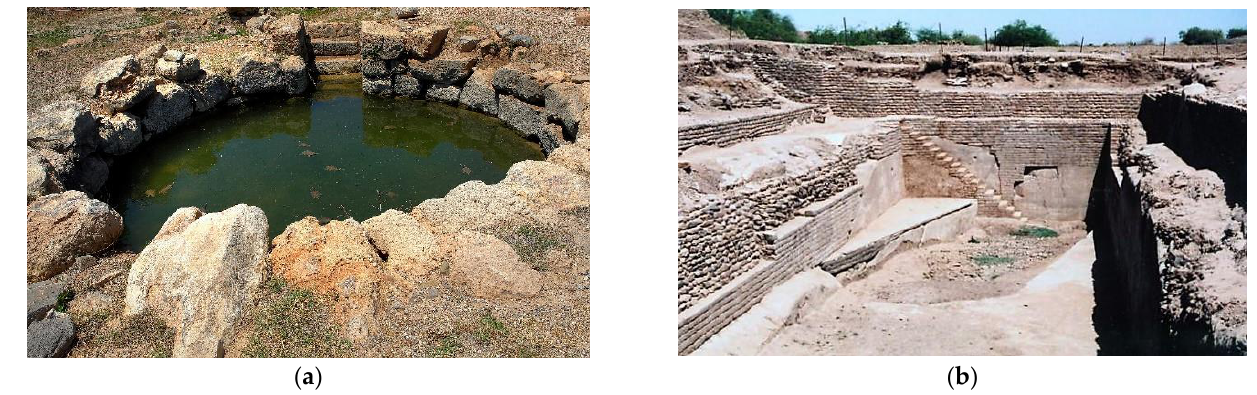
Figure 1. Rainwater harvesting technologies: ( a ) Minoan circular cistern (photo: A.N. Angelakis) and ( b ) Indus Valley Reservoir at Dholavira [15].